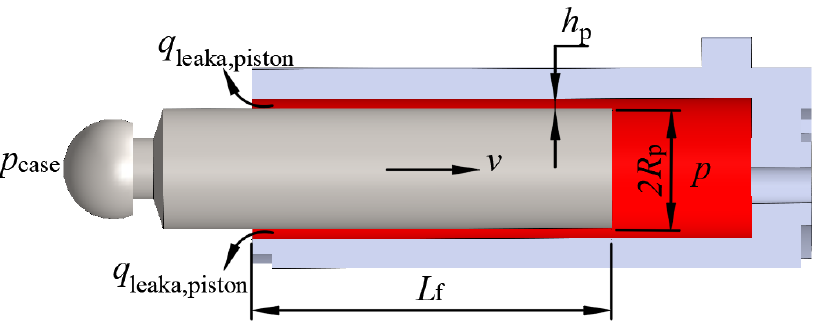
Figure 4. Schematic diagram of leakage flow of piston/cylinder interface.